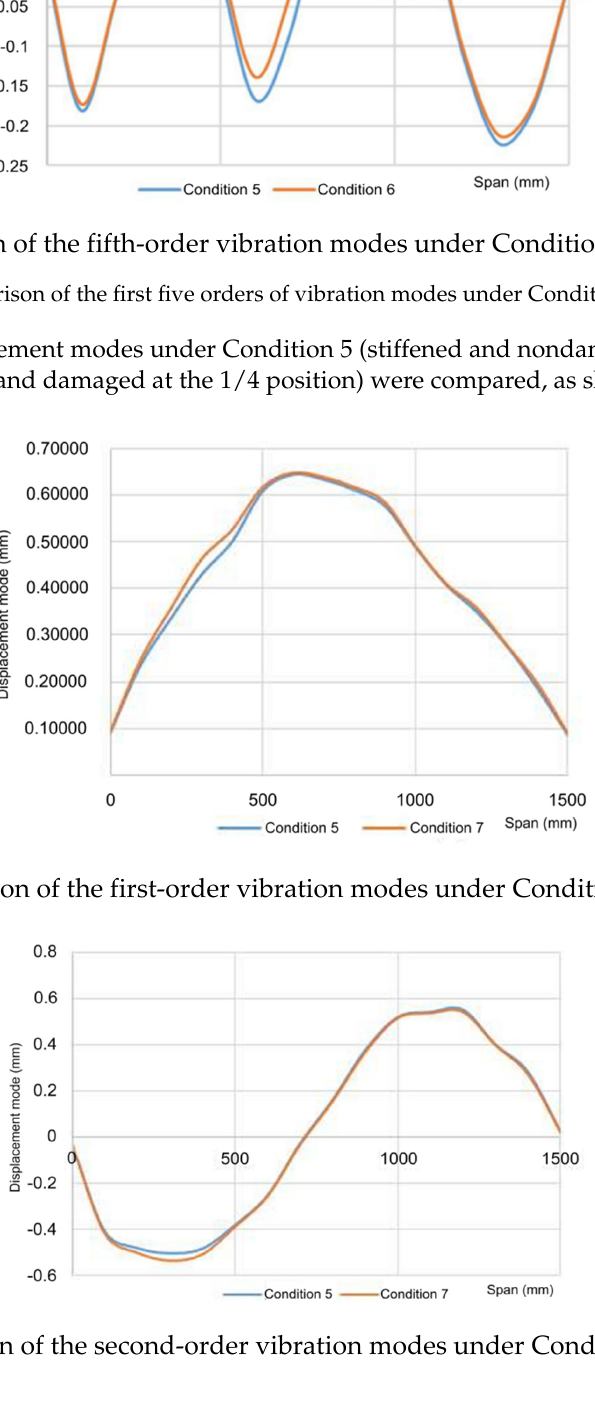
( b ) Comparison of the second-order vibration modes under Conditions 5 and 7. Figure 13. Cont